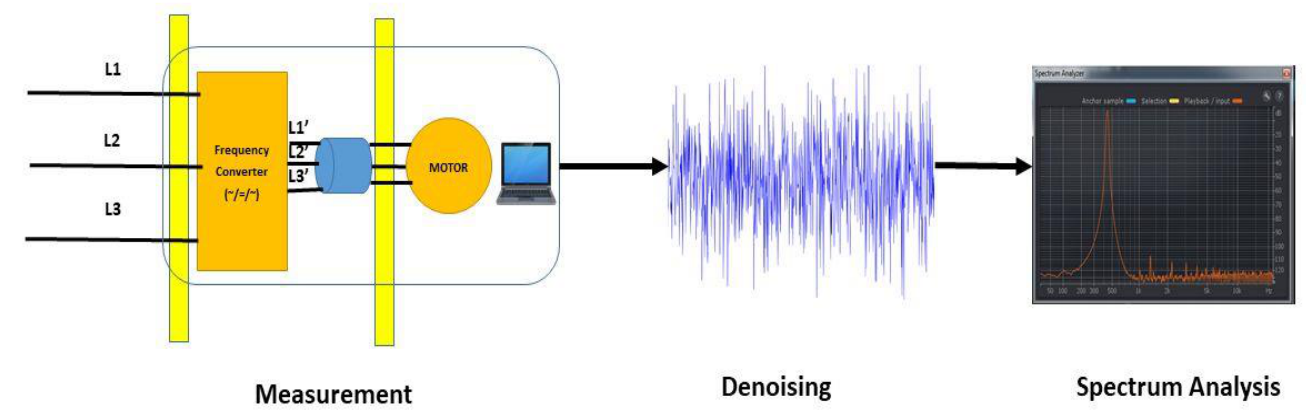
Figure 6. Block diagram of the frequency analysis.